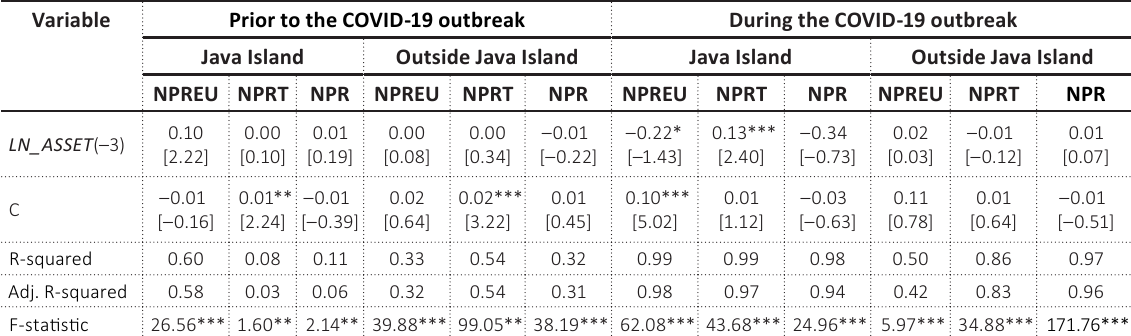
Table 1B (cont.). PVAR results